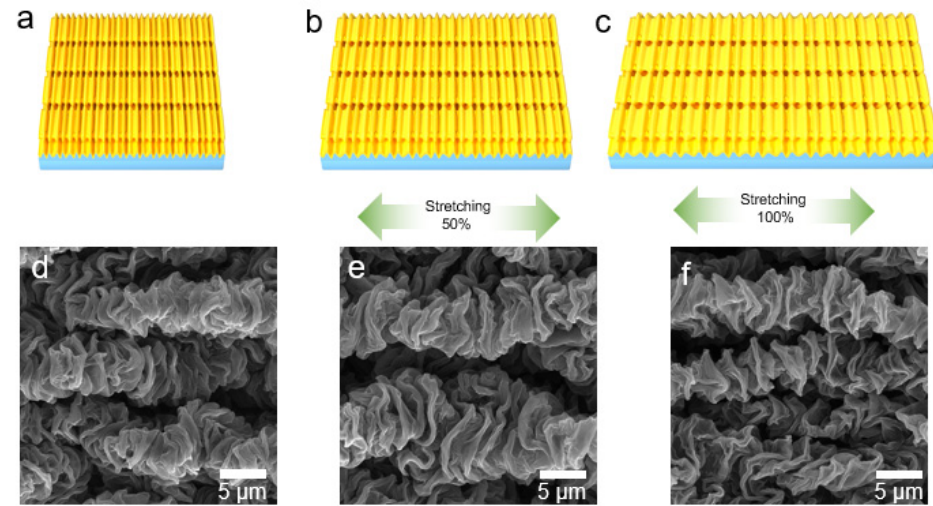
Figure 8. Diagrams of the stretching at ( a ) initial, ( b ) 50% strain, and ( c ) 100% strain. SEM images of stretching at ( d ) initial, ( e ) 50% strain, and ( f ) 100% strain.